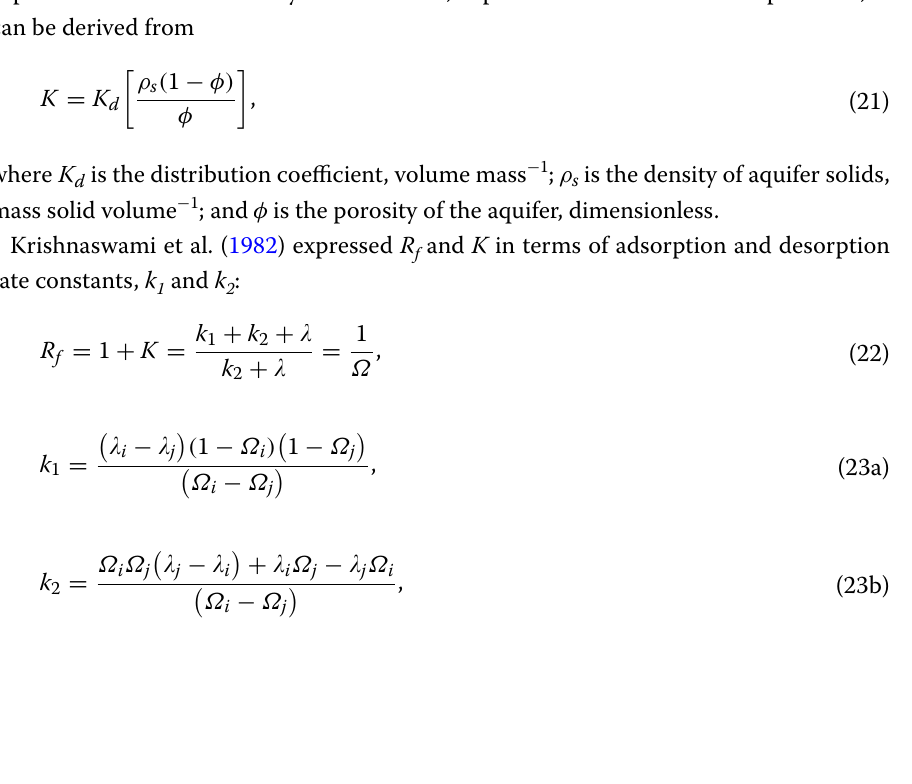
Data originate from Sun and Semkow